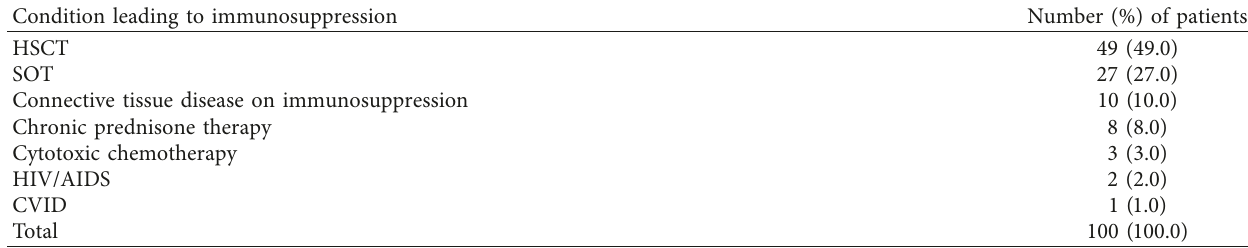
Table 1: Reason for immunocompromised